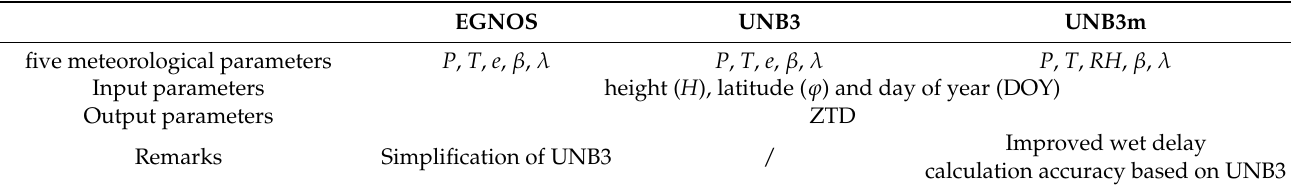
Table 2. Information of three empirical zenith tropospheric delay (ZTD) models. ( P —pressure, T —temperature, e —water vapor pressure, β —temperature lapse rate, λ —water vapor pressure height factor, RH —relative humidity, UNB—University of New Brunswick).